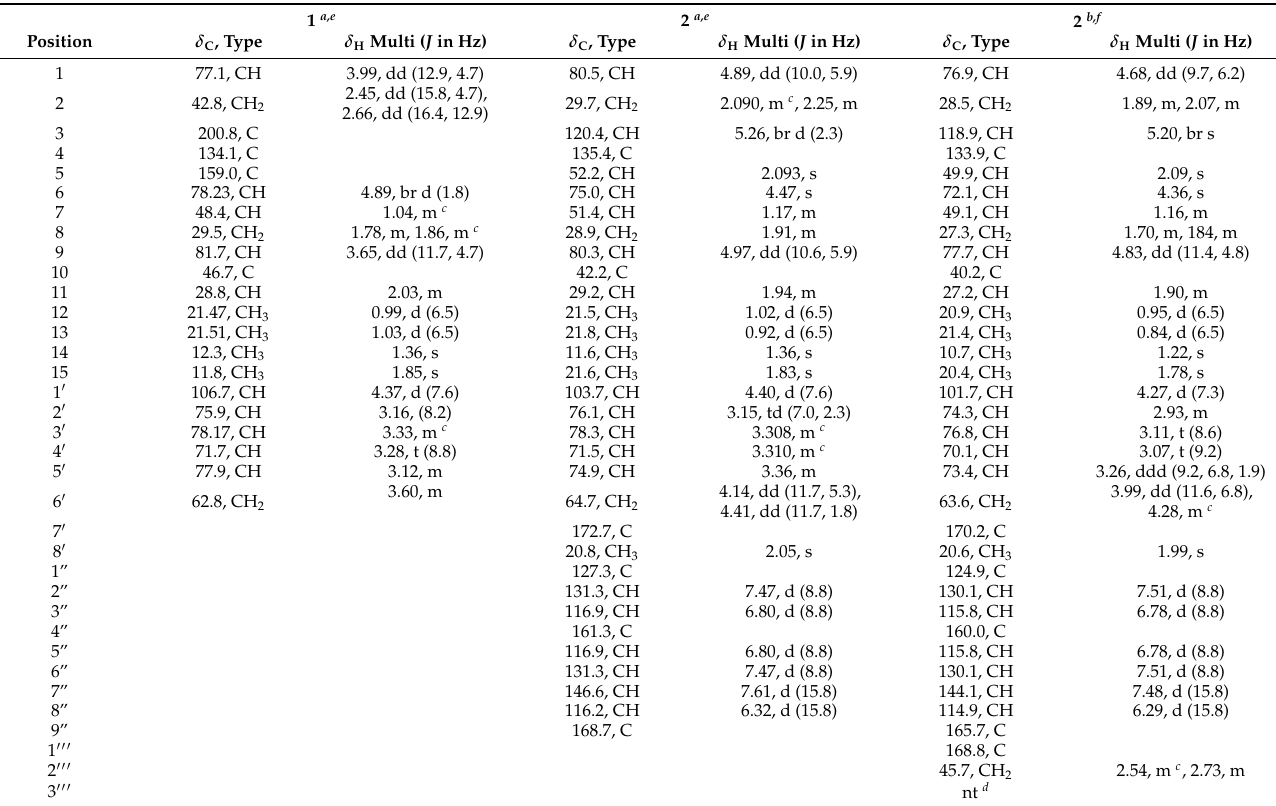
Table 1. 1 H and 13 C NMR data of compounds 1 and 2